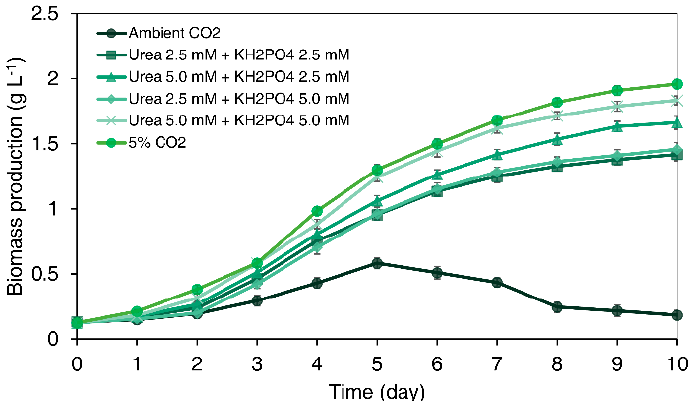
Figure 3. Biomass concentration of Chlorella sorokiniana UTEX 2714 with different combinations of urea and KH 2 PO 4 concentrations. Results represent the mean ± standard deviation (SD) of three replicates.